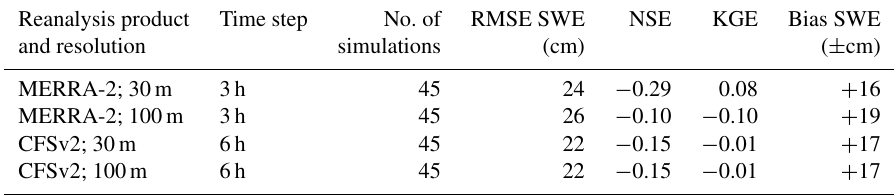
Table 1. Model calibration results. The best calibration results are given for each set of simulations for water years 2012–2016, along with the root mean squared error (RMSE), the Nash–Sutcliffe efficiency (NSE), the Kling–Gupta efficiency (KGE), and the mean bias error (bias). Reanalysis product Time step No. of RMSE SWE NSE KGE Bias SWE and resolution simulations (cm) ( ± cm) MERRA-2; 30m 3h MERRA-2;